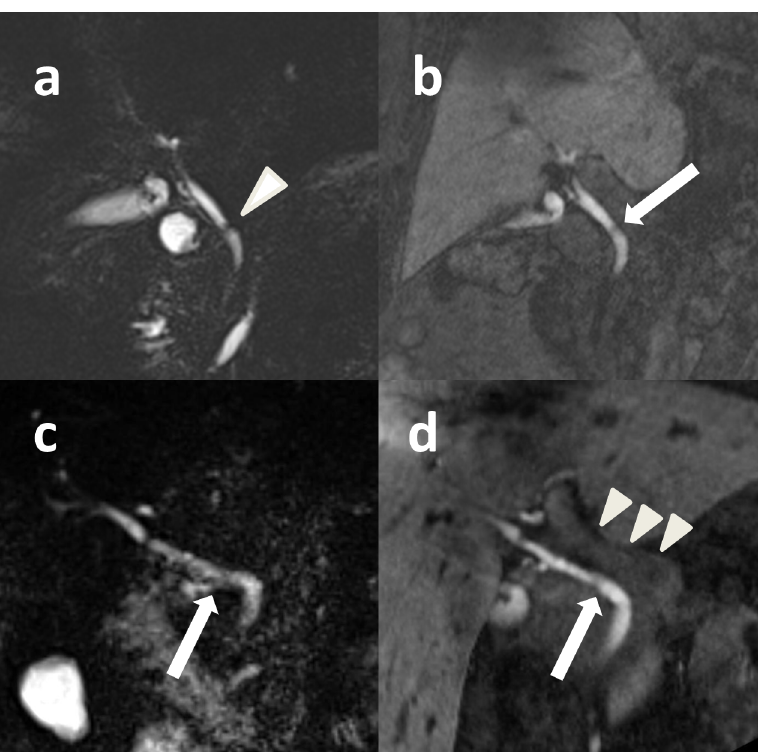
Fig 3. Image examples of T1 3D MRC complementing T2 MRCP. (a,b) In a 75 year-old female patient, on T2 MRCP (a), an artefact simulated a possible stenosis of the common bile duct (white arrowhead). With T1 MRC (b), a relevant stenosis could confidentially be excluded (white arrow). (c, d) In a patient with metastasized breast cancer due to movement of the bowel conspicuity of the central bilary structures was reduced on T2 MRCP Note improved depiction of the proximal part of the common hepatic duct (white arrow) on T1 3D MRC, which is slightly overlayered by duodenal filling on T2 MRCP. Additionally, there is a clear delineation of the portal vein on T1 MRC (white